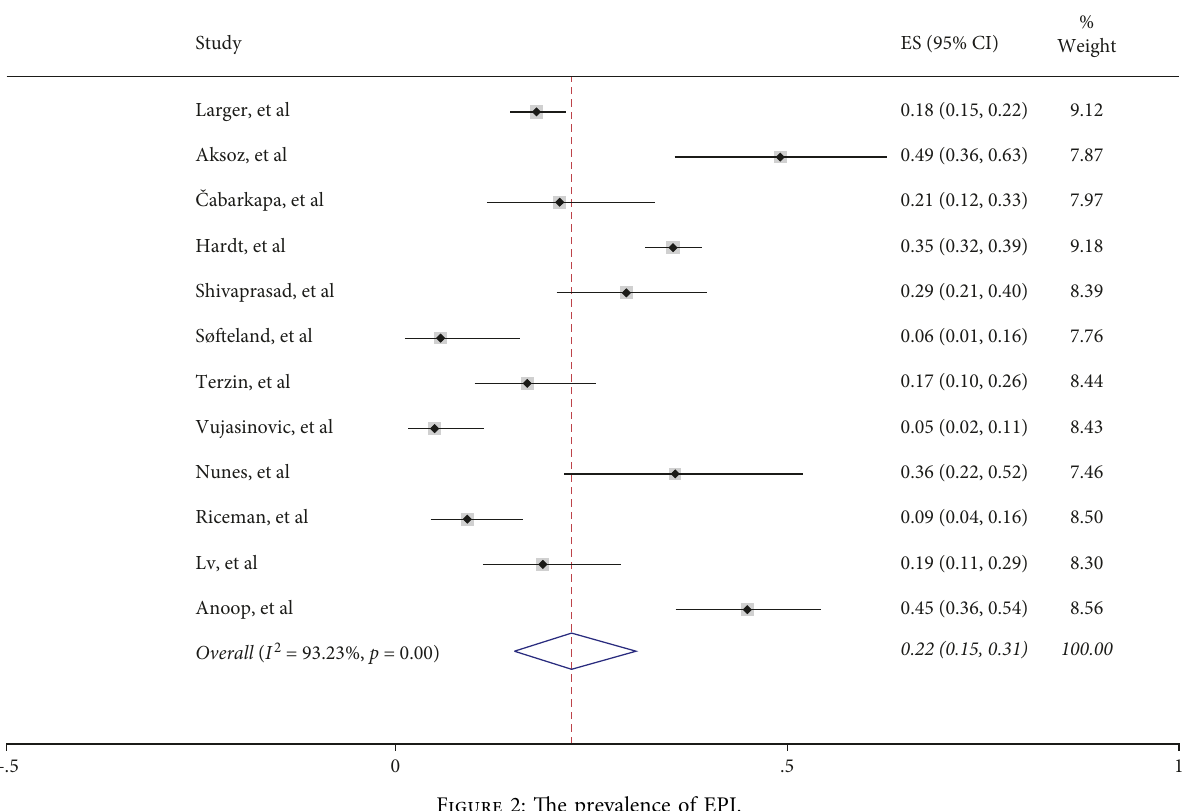
Figure 2: The prevalence of